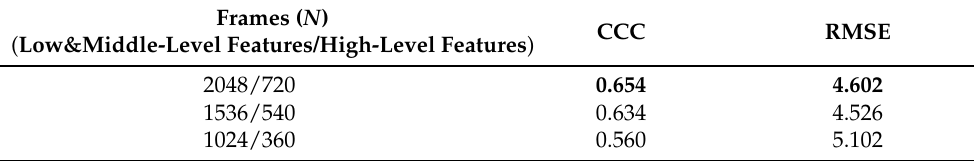
Table 7. The CCC and RMSE results for different frames of input on fixed 3-top modalities fusion regression single task. 2048/720 means that we select N = 2048 for low-level and middle-level features and N = 720 for high-level features. The data in bold means the results with better performance.